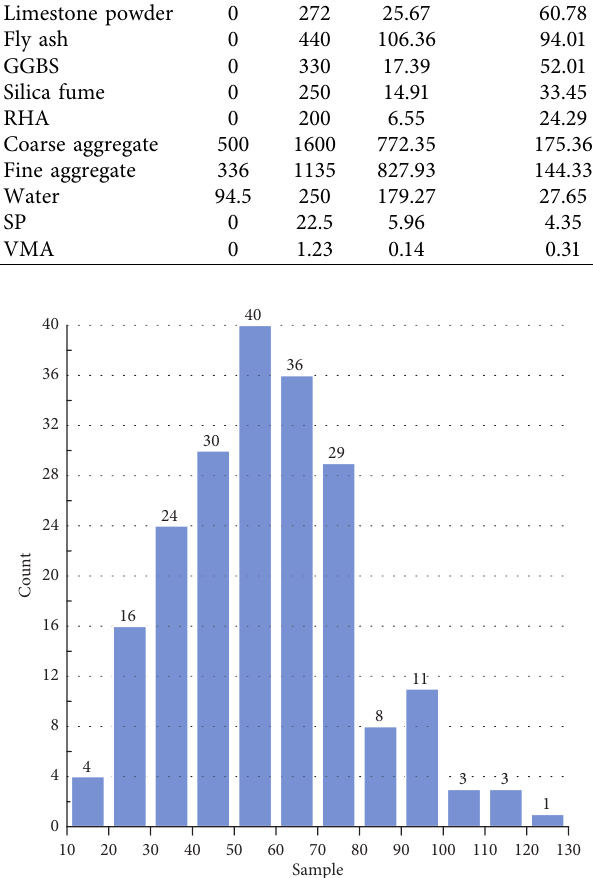
Figure 4: Distribution of compressive strength in the experimental